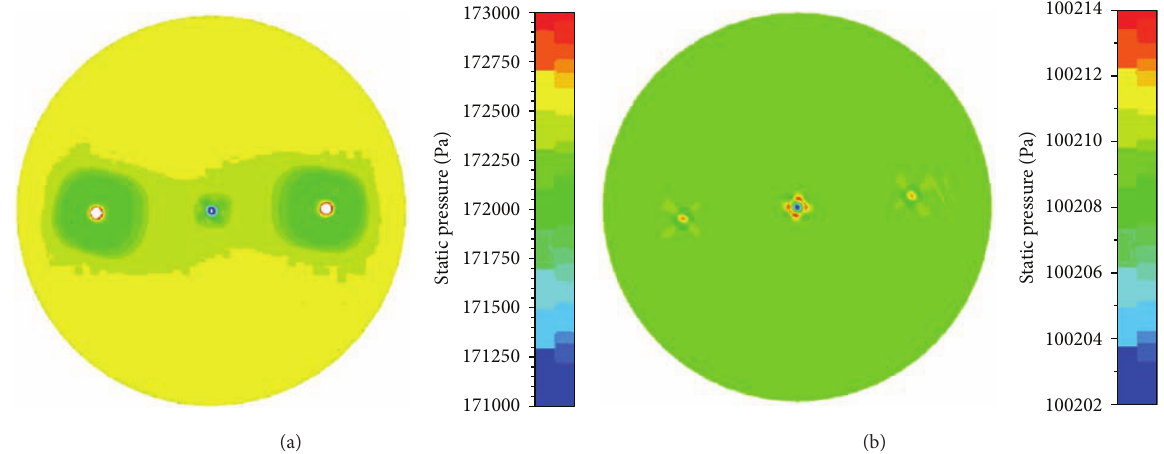
Figure 10: The pressure distribution graph of cell culture cavity: (a) the middle surface pressure distribution graph in inlet static pressure of 200,000 Pa, (b) the pressure field distribution when the flow rate is 2 × 10 −4